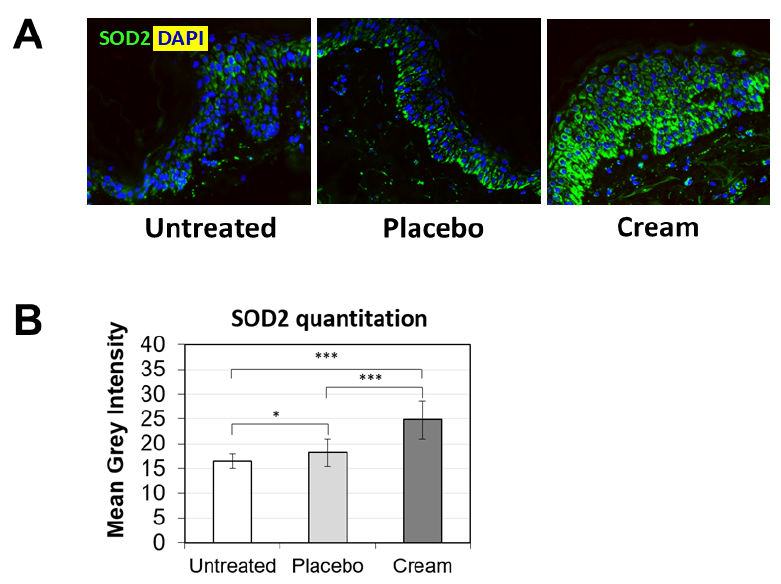
Figure 3. Assessment of SOD2 in the epidermis by immunofluorescence on human skin explants after eight days of topical treatment. ( A ) Representative images of skin sections of the untreated, placebo (negative control formulation), and cream (test product) groups, where SOD2 is visualized in green and the nucleus (DAPI) in blue (biological replicates n = 3). ( B ) SOD2 expression was quantitated by image processing and analysis of n = 5 images. Statistical comparison of the mean values was achieve using a t -test (* p < 0.05 and *** p < 0.001).